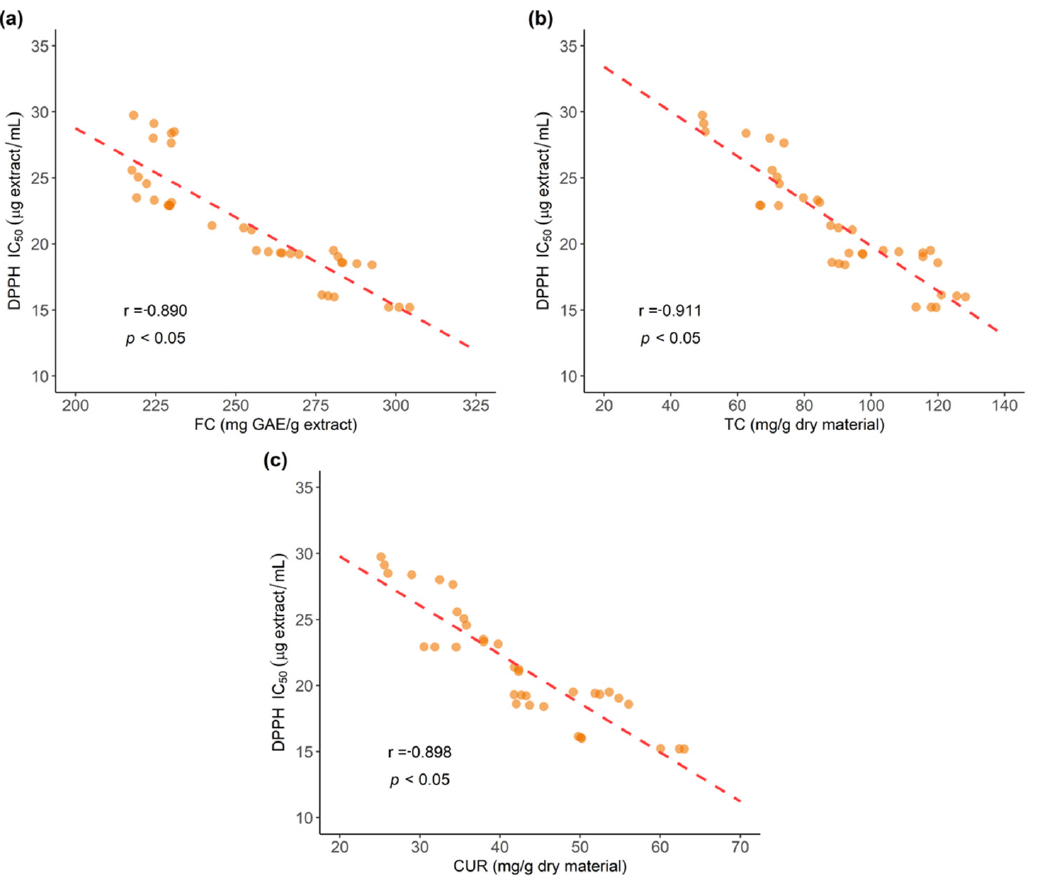
Figure 16. Correlation of antioxidant activity assessed by the DPPH method and: ( a ) Folin–Ciocalteu (FC) results; ( b ) Total curcuminoids (TC) content measured by UPLC-DAD; and ( c ) curcumin (CUR) content measured by UPLC-DAD.